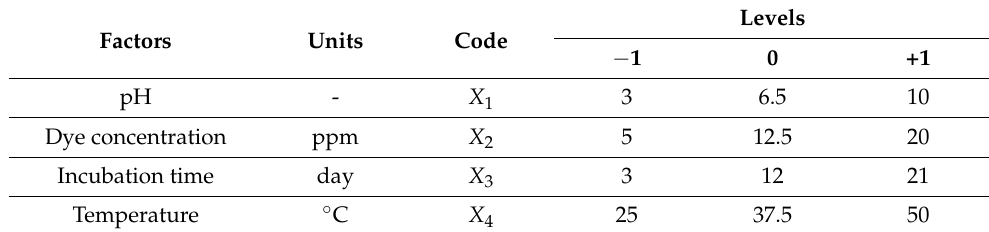
Table 1. Analysis of central composite design for the degradation of Basic Orange 2 dye.